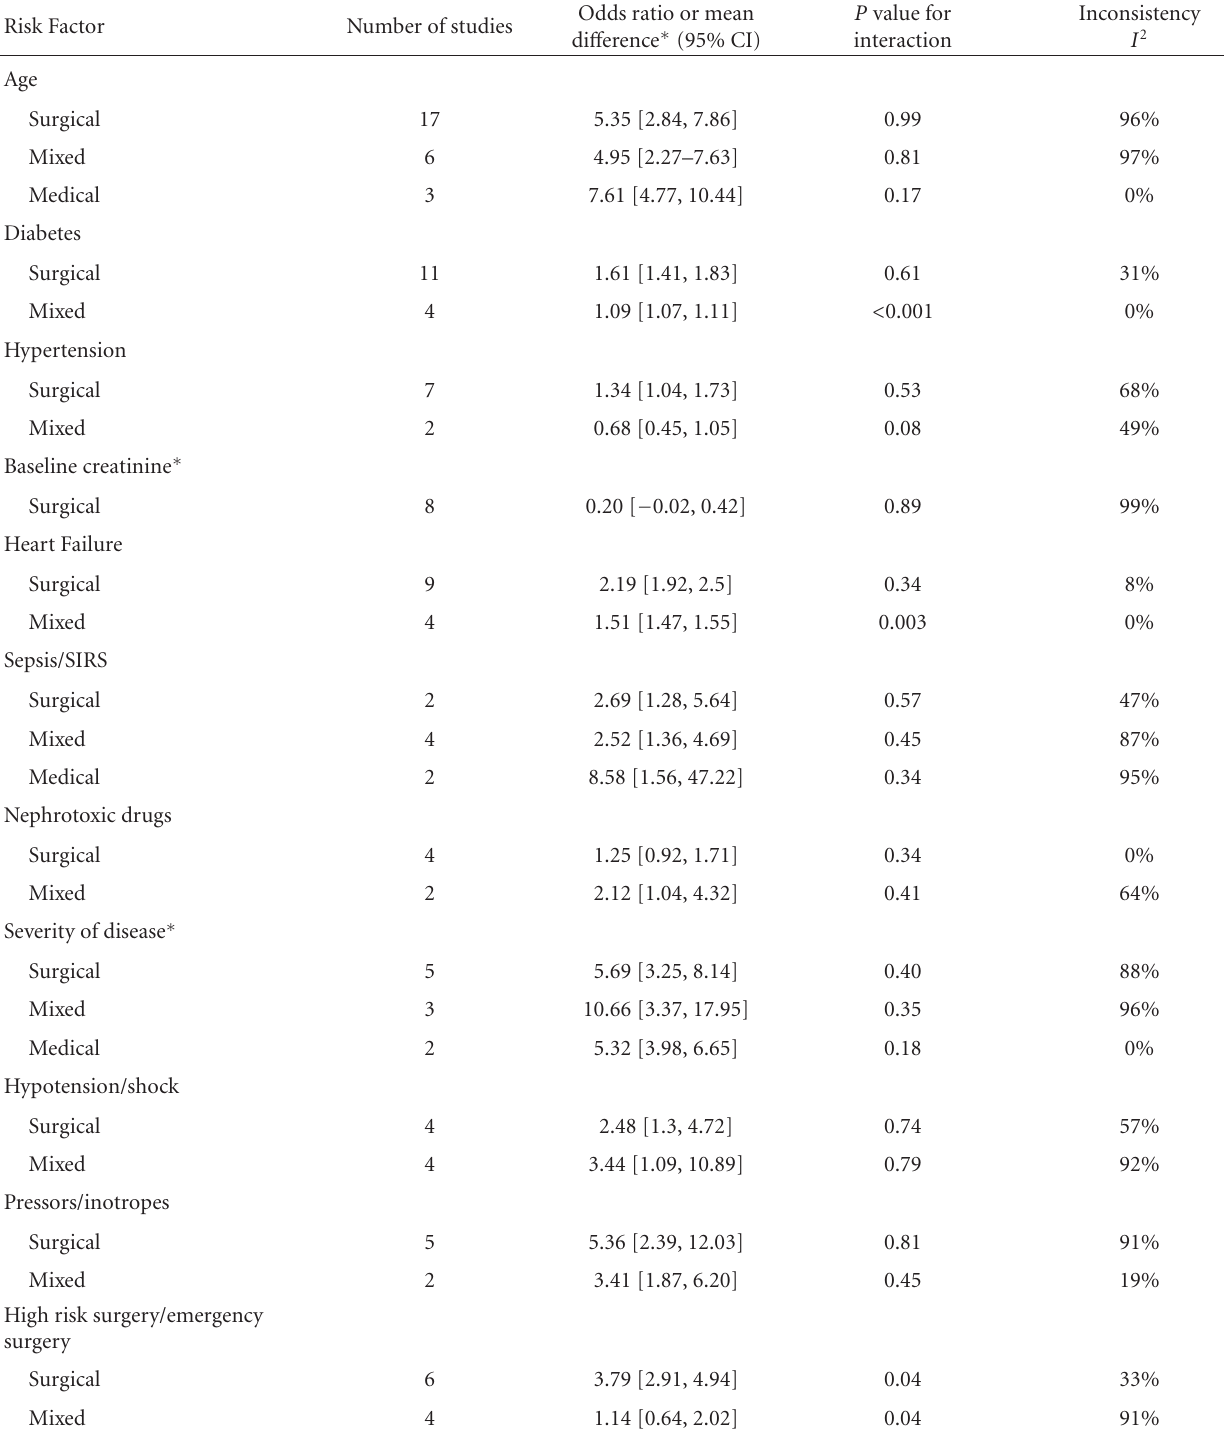
Table 4: Subgroups